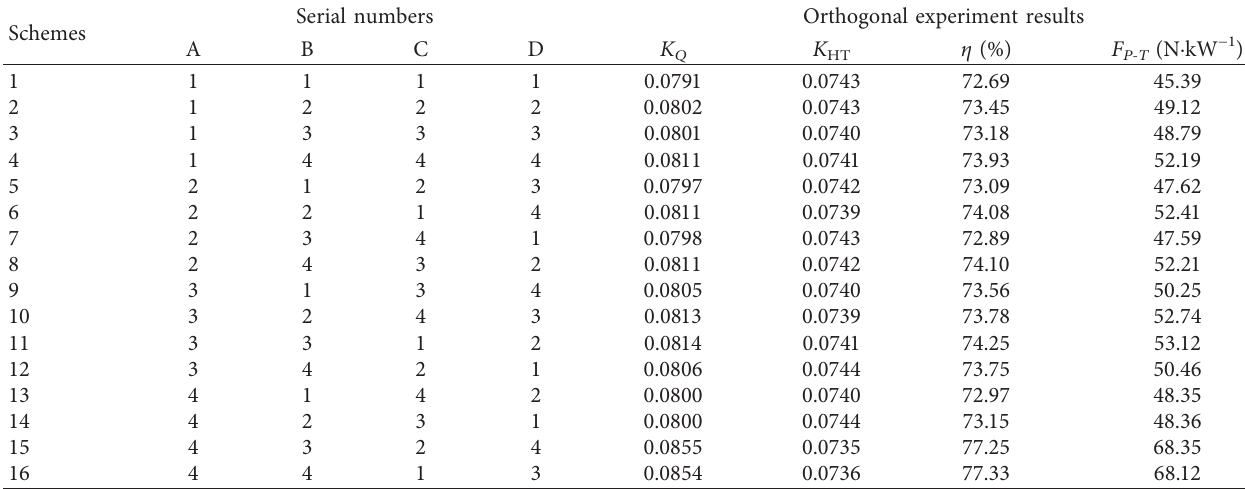
Table 3: Results of each orthogonal experiment